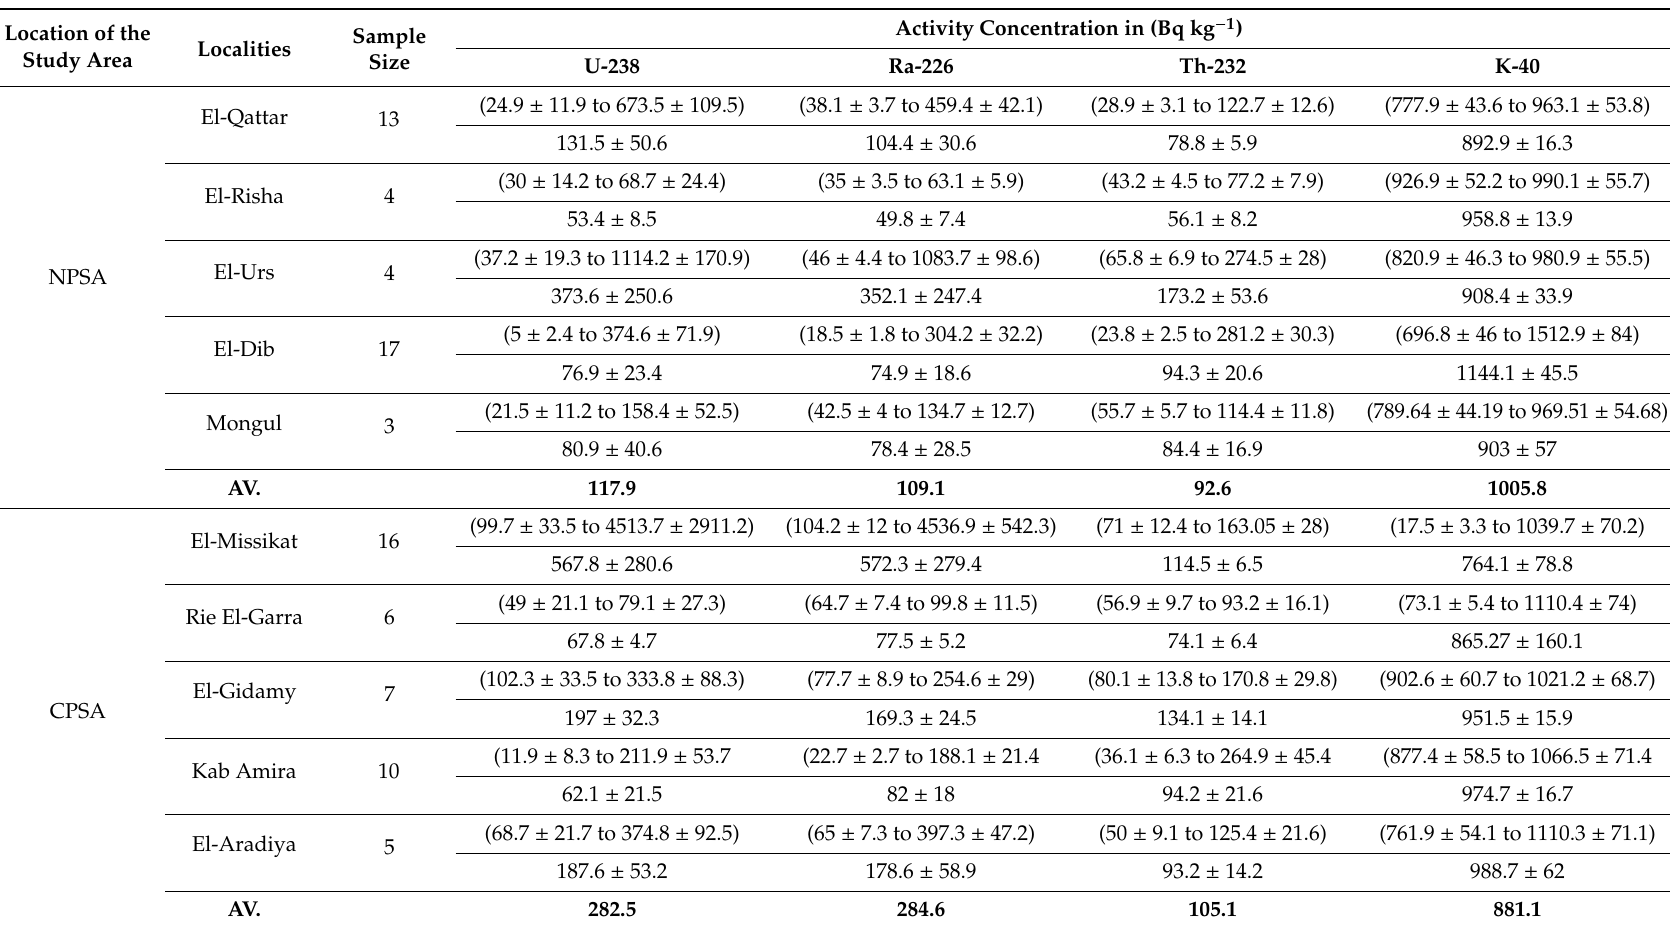
Table 1. Of the activity concentrations among the studied localities (activities (Bq kg − 1 ) of 226 Ra, 232 Th, and 40 K, range and average values) and with worldwide average. Location of